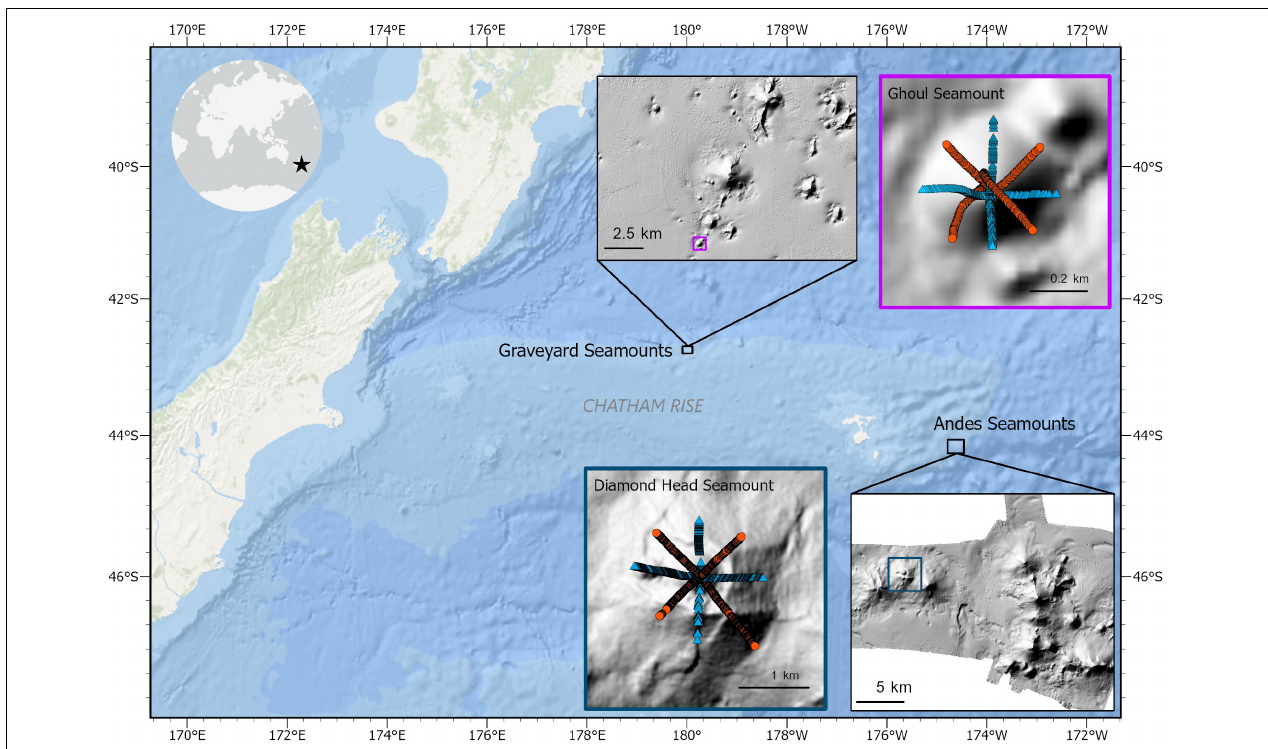
FIGURE 1 | Locations of the Graveyard (part of) and Andes seamount complexes on Chatham Rise off New Zealand. Map insets of Ghoul and Diamond Head show the locations of images which were included in the analyses of the two seamounts, as well as the annotation method which was used; orange circles represent images that were annotated only for substrate composition data, while blue triangles represent images annotated for both taxon abundance and substrate composition. Only images with visible seafloor areas between 1 and 5 m 2 and located within the seamount basal perimeters are included in this figure (see section “Methods” and Supplementary Figure 1 for